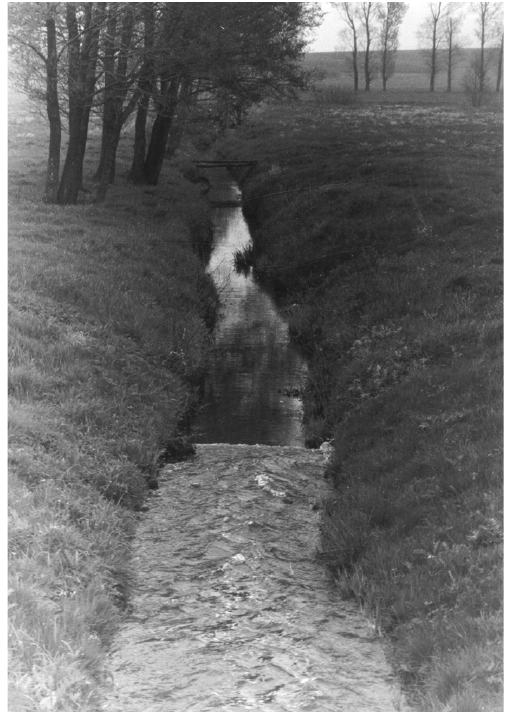
Figure 3. Experimental reach of the Olszanka watercourse (cour- tesy of Jerzy Szkutnicki).